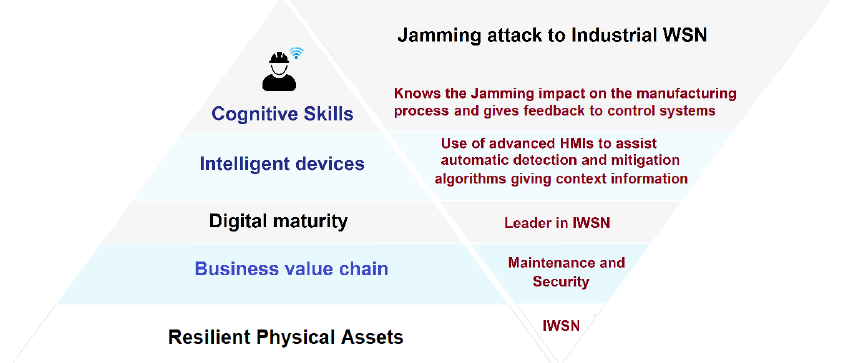
Figure 14. Worker 5.0 collaboration in Jamming Detection and Mitigation.